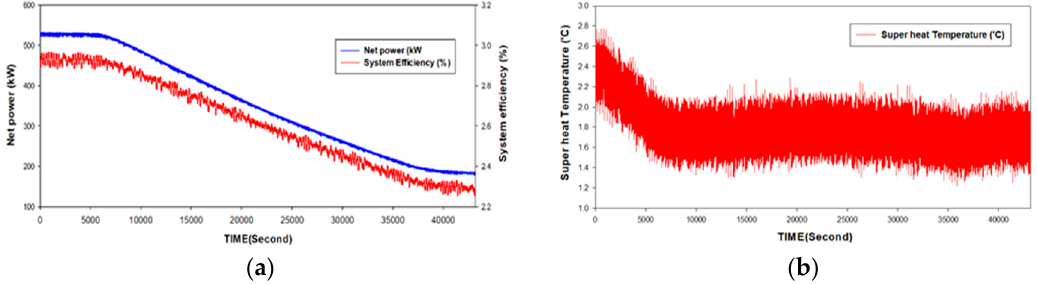
Figure 9. Dynamic variations in turbine with PID controller: ( a ) refrigerant superheat of turbine inlet; ( b ) power and system efficiency. ( b ) power and system e ffi